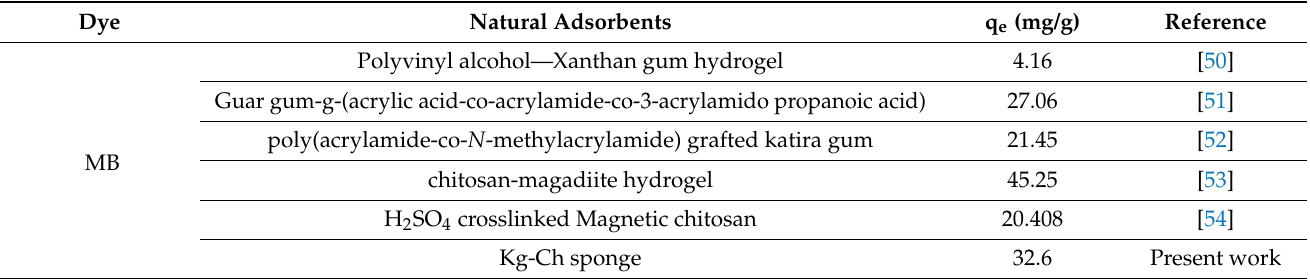
Table 4. Maximum dye (MB and MO) removal data: comparison of dye adsorption by Kg-Ch sponge with various other